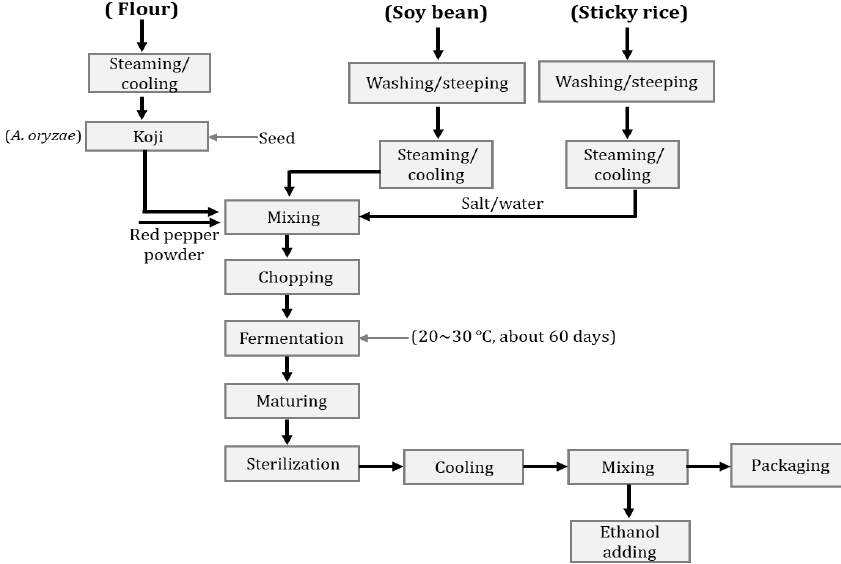
Figure 9. General manufacturing process of modified gochujang.